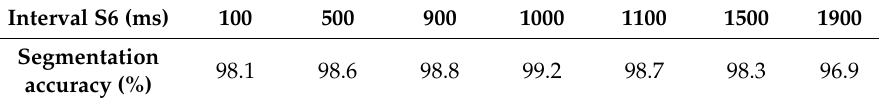
Table 3. Segmentation accuracy with different time-window widths of interval